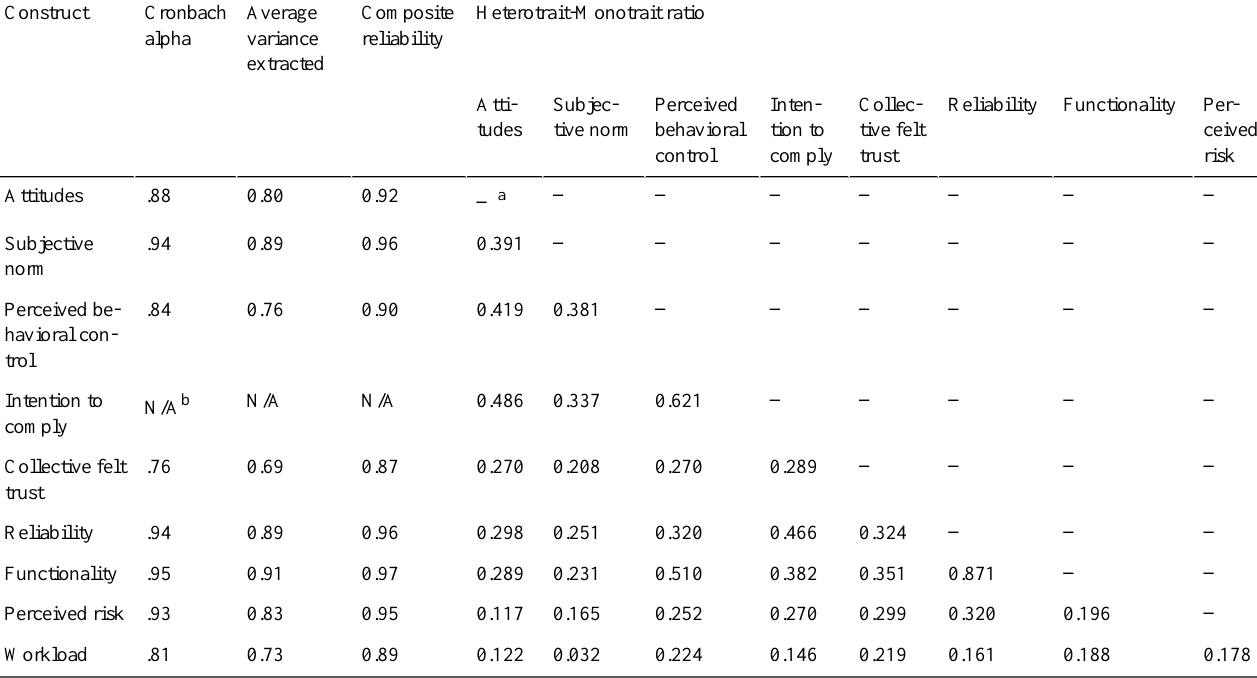
Table 4. Reliability and validity of measurement